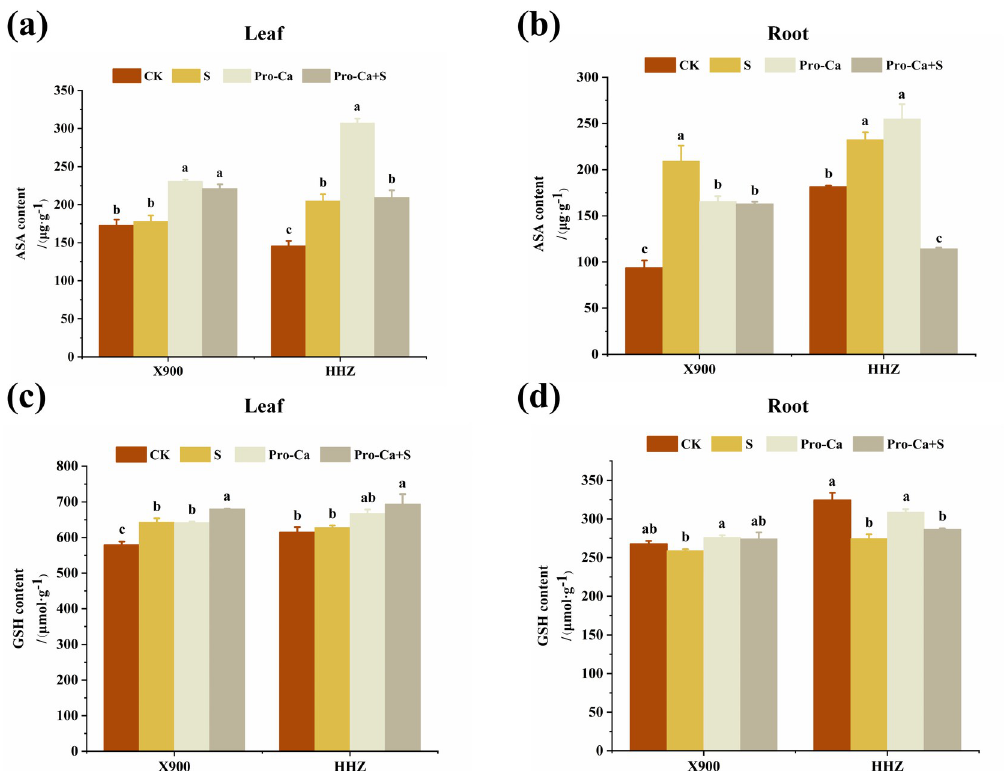
Fig 6. The alleviating effect of exogenous prohexadione-calcium (Pro-Ca) on the antioxidant enzyme activity of rice under salt stress. The ascorbate (AsA) content activity in the X900 (left) and HHZ (right) leaves (a) and roots (b); The glutathione (GSH) in the X900 (left) and HHZ (right) leaves (c) and roots (d). Abbreviations: CK (water spraying + 0% NaCl), S (water spraying + 0.3% NaCl), Pro-Ca (100 mg � L -1 Pro-Ca leaf spraying + 0.3% NaCl), and Pro-Ca + S (100 mg � L -1 Pro-Ca leaf spraying + 0.3% NaCl). The numerical value represents the mean ± SE ( n = 3), and different lowercase letters indicate significant differences according to Duncan’s test ( p < 0.05).